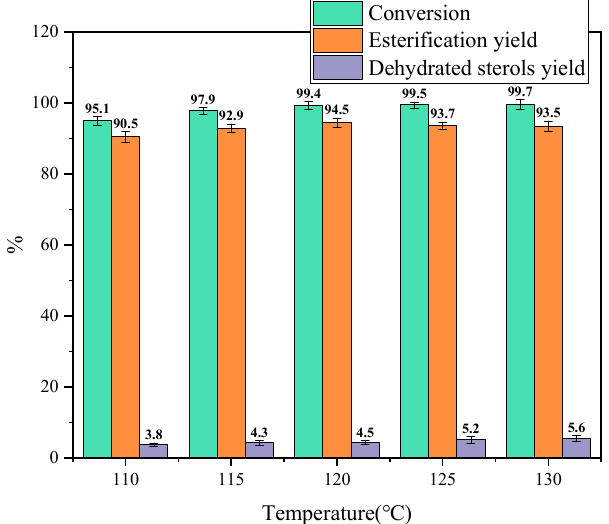
Figure 4. Effect of reaction temperature. Reaction conditions: 2 mmol pine sterols, 3 mmol oleic acid, 1.5% catalyst (based on the mass of pine sterols), 5 h.